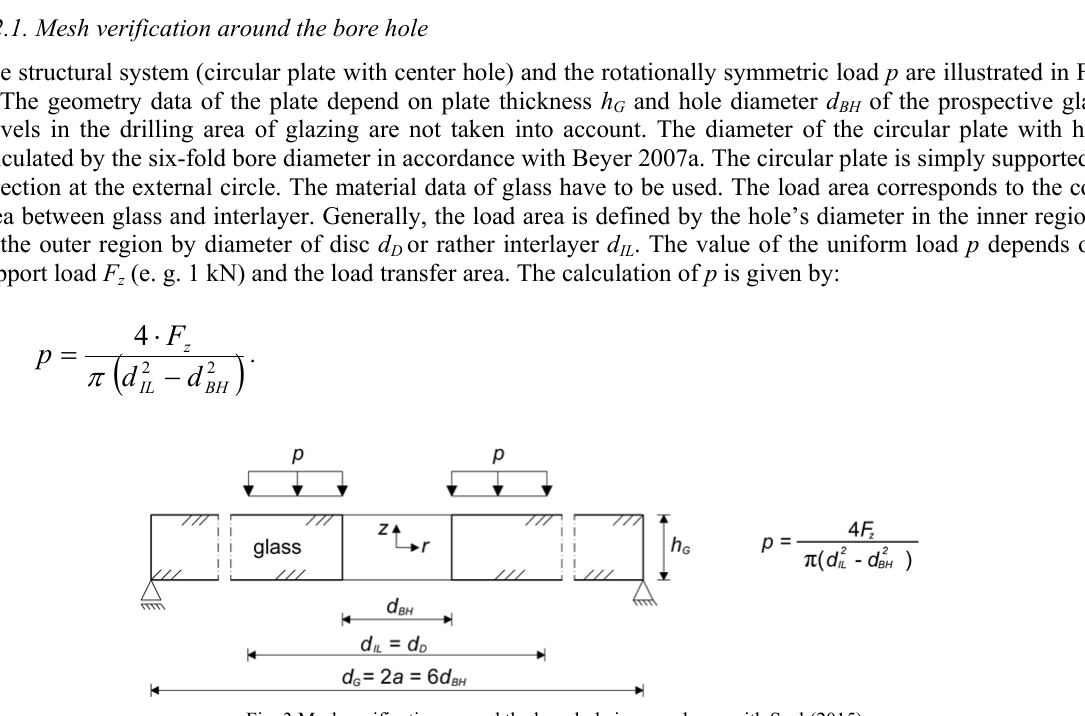
Fig. 3 Mesh verification around the bore hole in accordance with Seel